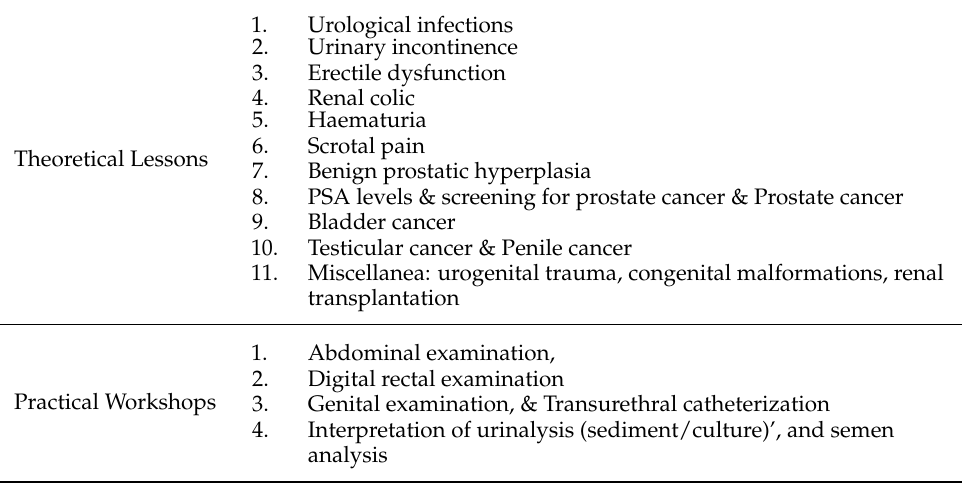
Table 2. Theoretical and practical content